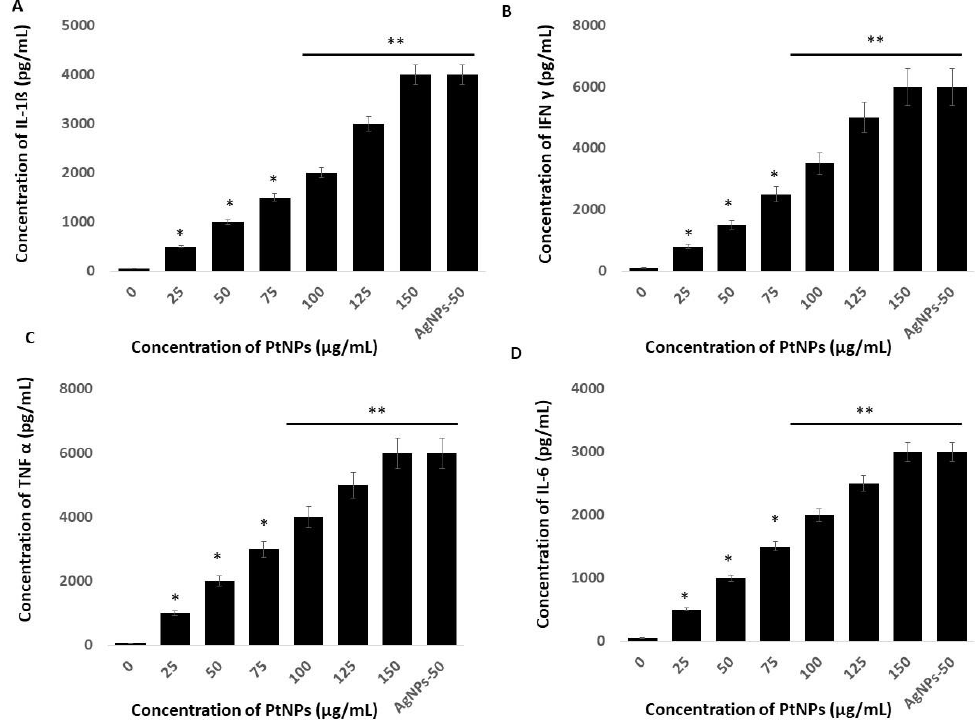
Figure 11. Effect of PtNPs on cytokine and chemokine levels. THP-1 cells were treated with various concentrations of PtNPs (25 – 150 µg/mL) for 24 h. ( A ) IL-1 beta; ( B ) IFNγ, ( C ) TNFα, and ( D ) IL-6 cytokine concentration was measured in the cell culture supernatant after PtNP treatment. Results are expressed as mean fold change ± standard deviation from three independent experiments. The treated groups showed statistically significant differences from the control group by the Student’s t -test (* p < 0.05; ** p < 0.01). * significant; ** highly significant.